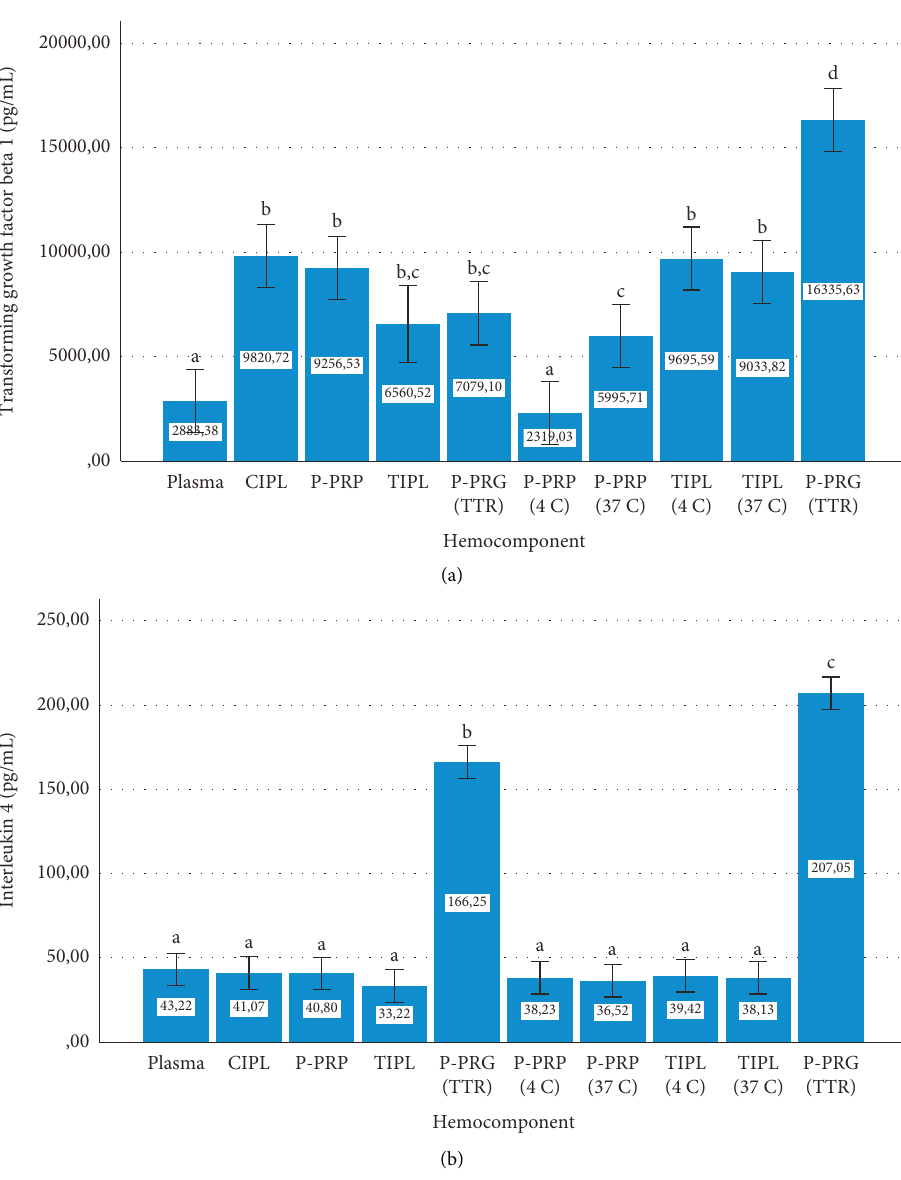
Figure 10: Overall mean ± sd transforming growth factor beta 1 (a) and interleukin 4 (b) concentrations either conserved or released from hemocomponents. a–c Different lowercase letters denote significant ( P < 0 . 001) differences between hemocomponents by the Games–Howell post hoc